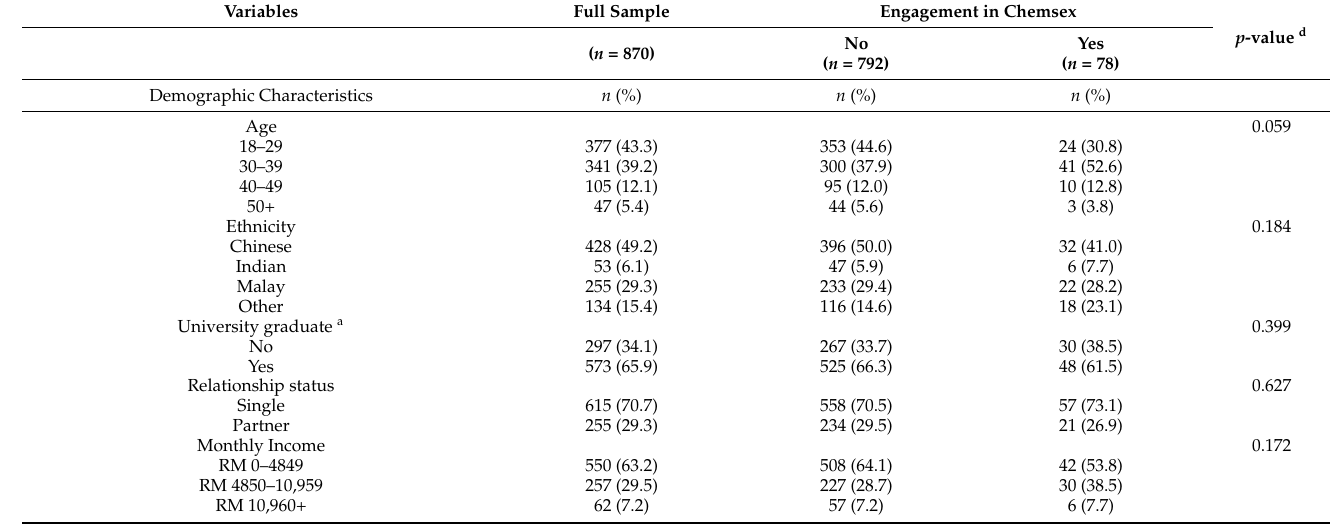
Table 1. Characteristics of participants stratified by recent engagement in chemsex ( n =